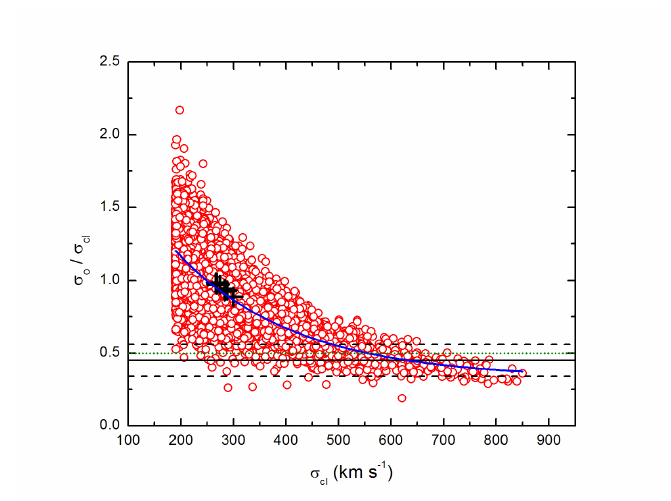
Fig. 6 σ o of BCGs in r -band with respect to σ cl of host clusters and groups as a function of σ cl . Error bars represent the average values of σ o / σ cl in different σ cl bins with errors. The blue solid line shows the best exponential fit to our sample. The black solid and dashed lines show the predicted relation and the 1 σ deviation from simulation done by [3], respectively. The green dotted line is the predicted relation from simulations done by